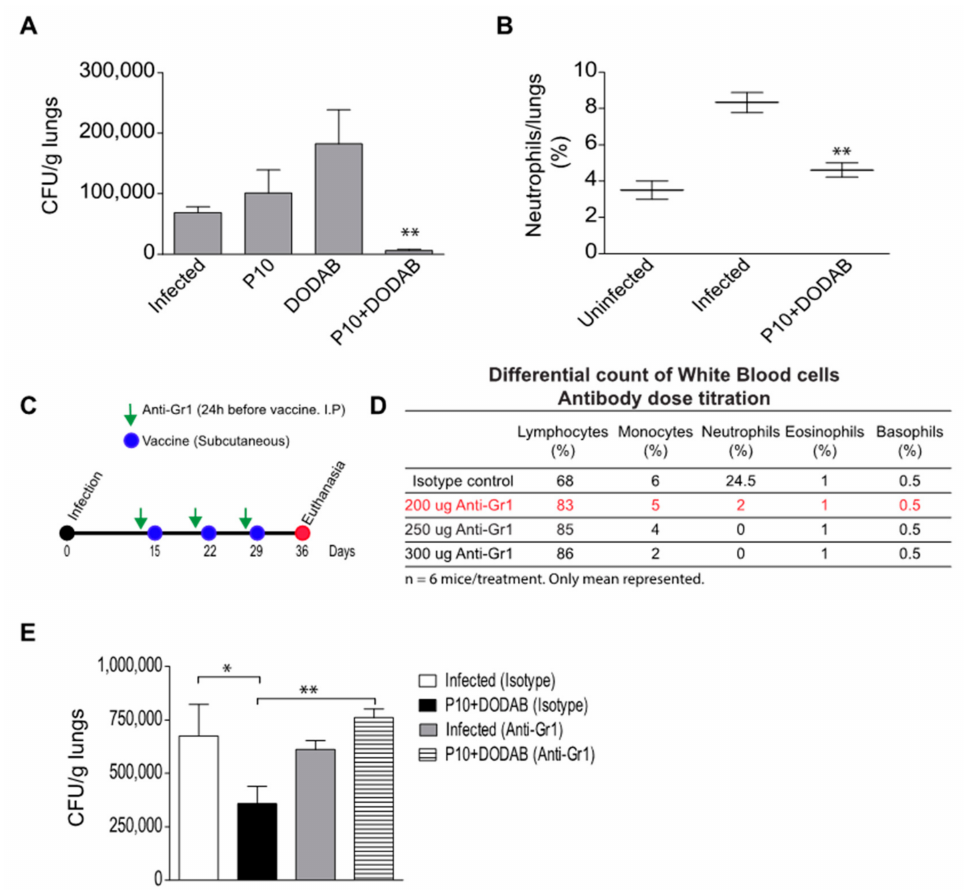
Figure 1. Effectivity of a therapeutic vaccine against paracoccidioidomycosis is associated with the presence of neutrophils in the immunization site. Mice were infected with P. brasiliensis (Pb18 strain), and after 15 days the animals were treated or not with a therapeutic P10+DODAB vaccine, P10 only or DODAB alone (three doses administered one week apart). The mice were euthanized 36 days after infection, and ( A ) the fungal load was determined by CFU and ( B ) the number of neutrophils in the lungs was measured by flow cytometry. In another model the neutrophils were depleted 24 h before each vaccination ( C ) and the fungal burden in the lungs was measured 36 days after infection. The optimal dose of antibody was previously titrated in uninfected and unvaccinated animals, and represented in ( D ). ( E ) The neutrophil depletion was achieved through the systemic (intraperitoneal route) administration of the anti-Gr1 antibody. Data are representative of three independent experiments (mean ± SD). * p ≤ 0.05, ** p ≤ 0.005, One-Way ANOVA test with the Tukey test for multiple